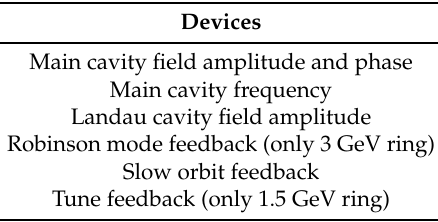
Table 1. Feedback systems used in the MAX IV storage rings.